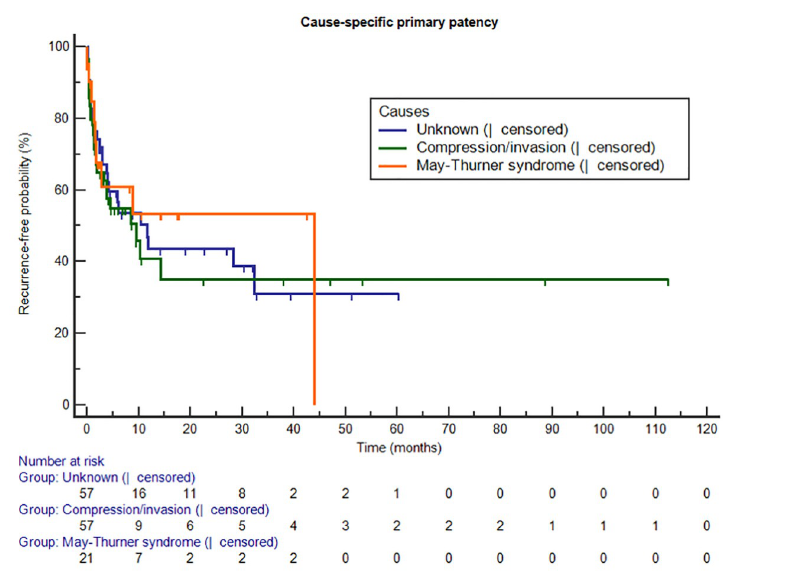
Table 5. Subgroup analysis of outcomes based on the cause of ilio-femoral deep vein thrombosis (IFDVT). Unknown (n =